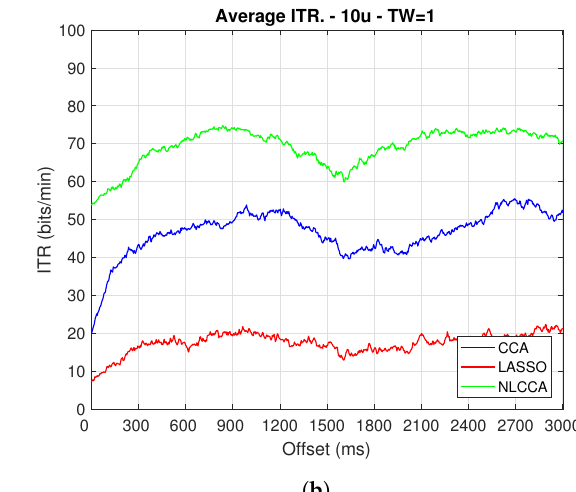
Figure 9. One-second sliding window for ( a ) Accuracy and ( b )